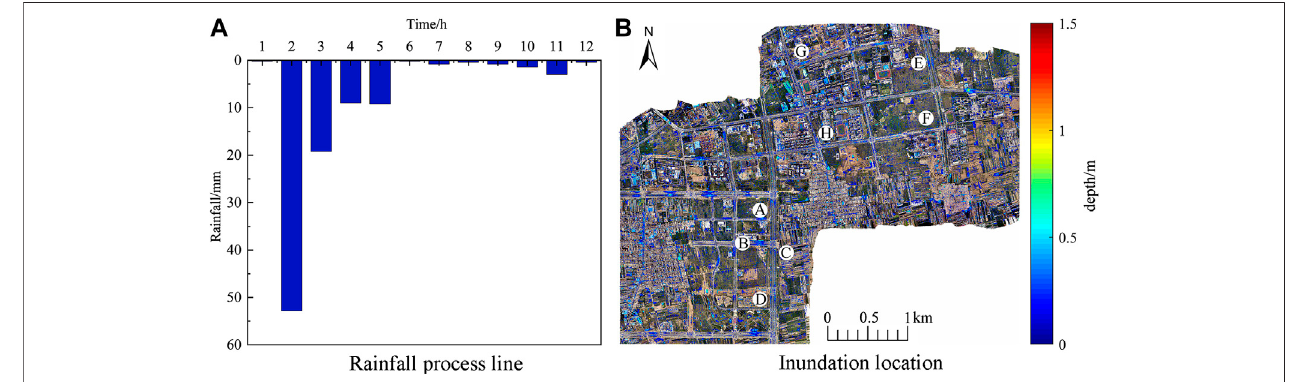
Frontiers in Earth Science |